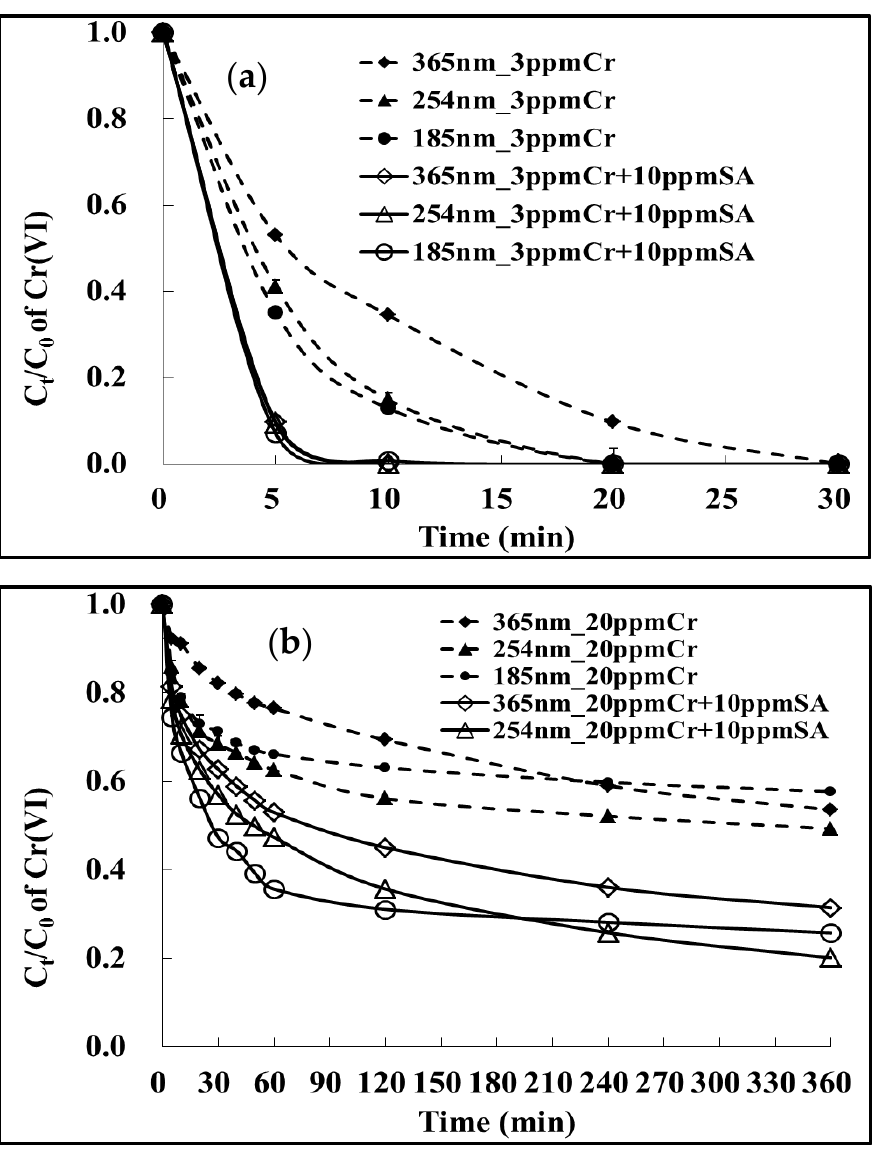
Figure 2. Effects of the wavelength factor on residuals of Cr(VI) after photo-reduction by TiO 2 ( a ) Cr(VI) 3 mgL −1 ( b ) Cr(VI) 20 mgL −1 .